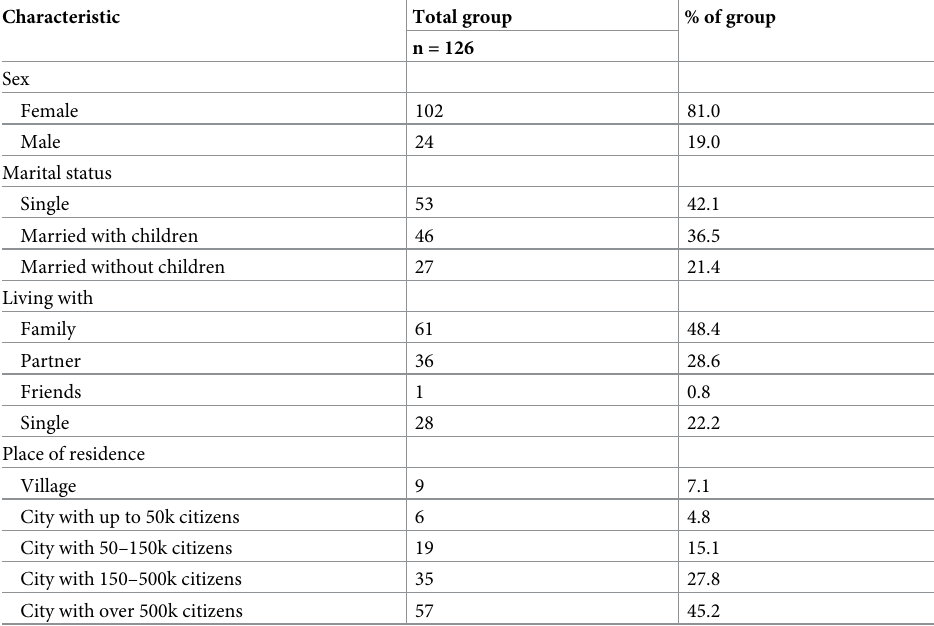
Table 1. Sociodemographic characteristics of the studied group of